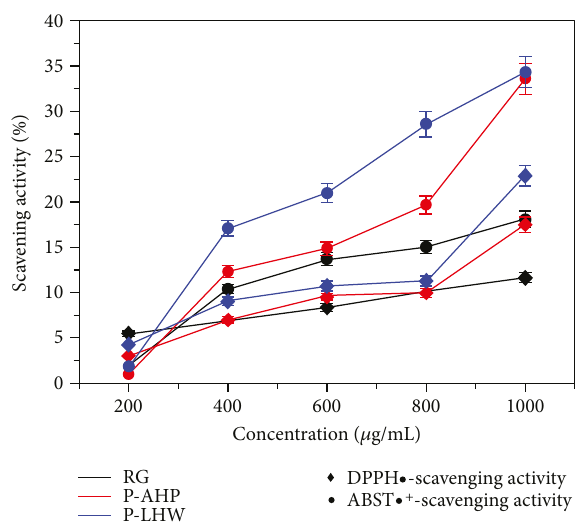
Figure 4: Activities of the polysaccharide